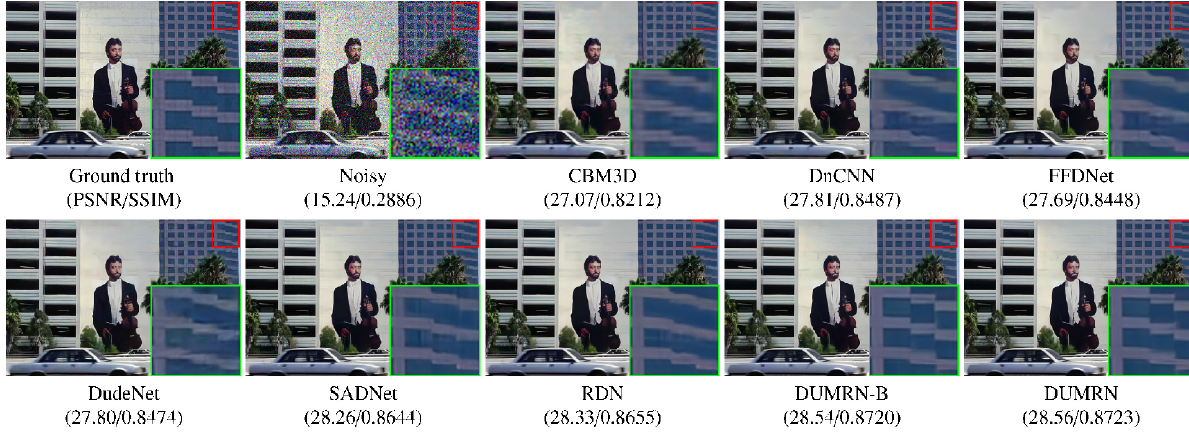
Fig. 5 Color image denoising results on image 119082 from CBSD68 with noise level σ = 50.